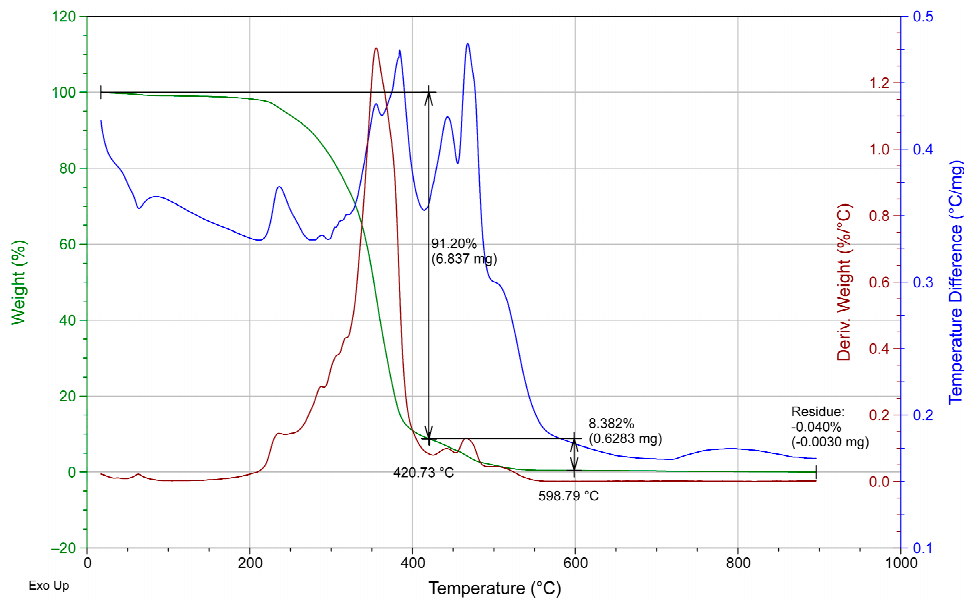
Figure A4. DSC-TGA for the SA-B commercial coating.